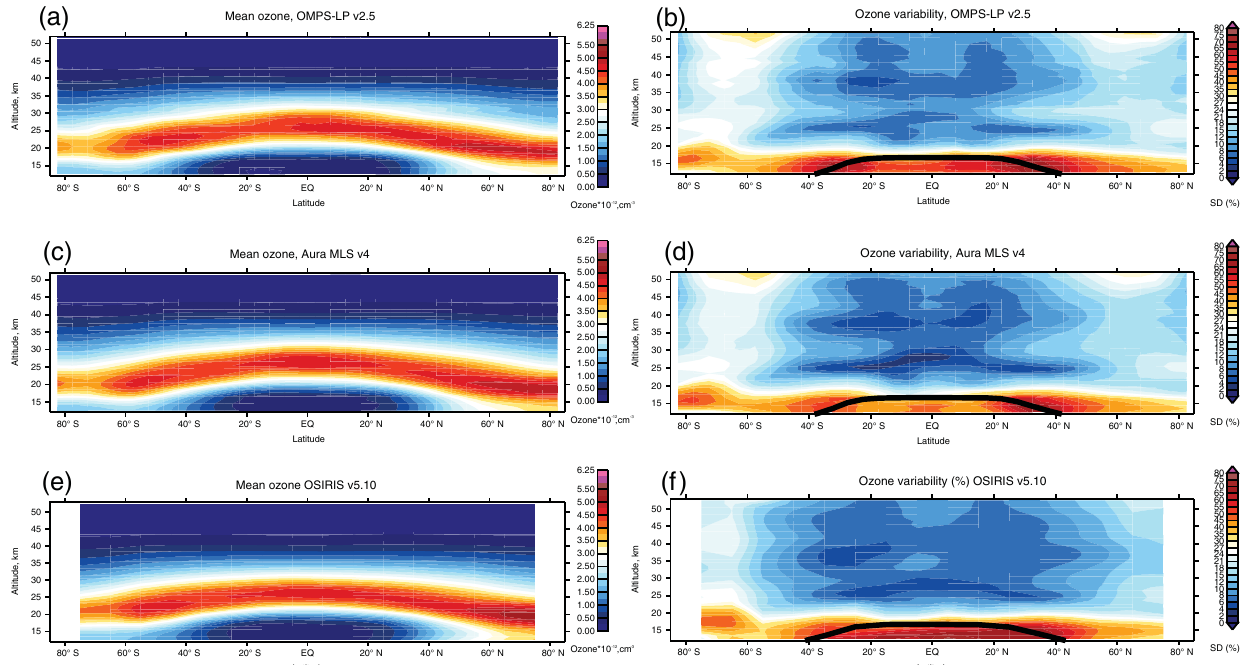
Figure 12. Mean ozone values (left column) in cm − 3 and ozone variability (right column) in % as functions of latitude and altitude for three satellite instruments: OMPS LP ( a–b ), Aura MLS ( c–d ) and OSIRIS ( e–f ). Data for OMPS LP and MLS are shown on 5 ◦ latitude grid, while OSIRIS values are shown on 10 ◦ latitude grid. The ozone variability is calculated as 1 σ standard deviations from all individual ozone retrievals relative to the instrument means (shown in the left